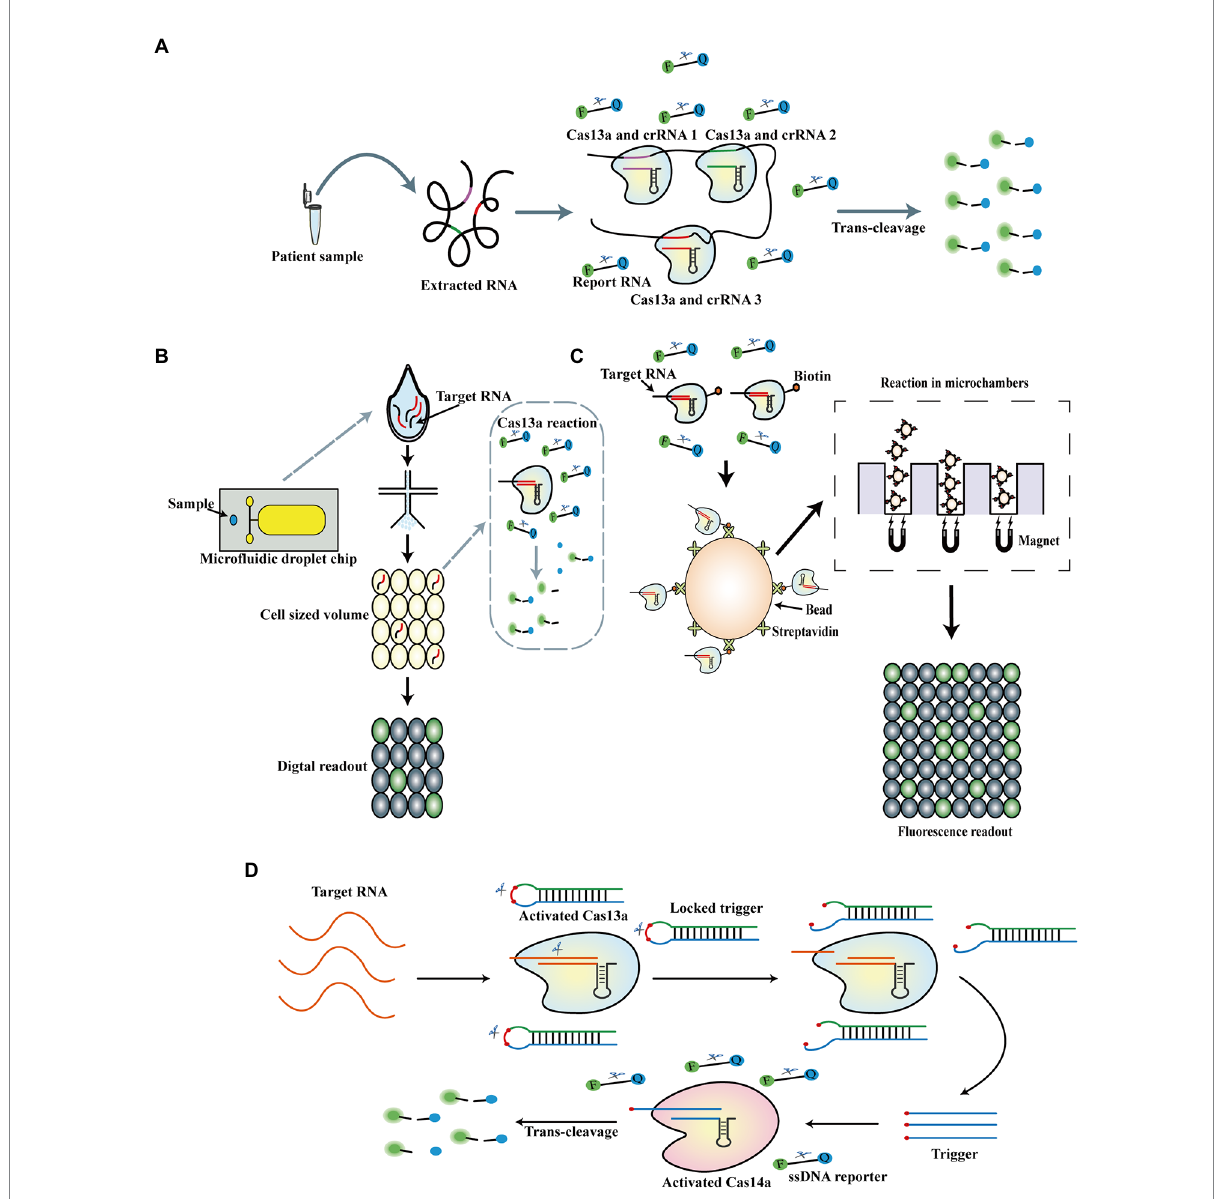
FIGURE 4 Cas13a-based nucleic acid amplification-free biosensors. (A) Schematic of Cas13a-based biosensor using combination of crRNAs. Two or three crRNAs targeting distinct regions of SARS-CoV-2 genome are mixed to increase the sensitivity of Cas13a-based detection. (B) Schematic of ultralocalized Cas13a assay. The Cas13a reaction is confined in cell-like-sized reactor to enhance the local reaction concentration. (C) Schematic of opn-SATORI. In this detection, biotin-labeled Cas13a complexes are captured by streptavidin-labeled magnetic beads, which are concentrated by the magnetic force into microchambers and are activated in the presence of target RNAs. (D) Schematic of casCRISPR. The trans-cleavage activities of both Cas14a and Cas13a reactions are orderly combined to detect